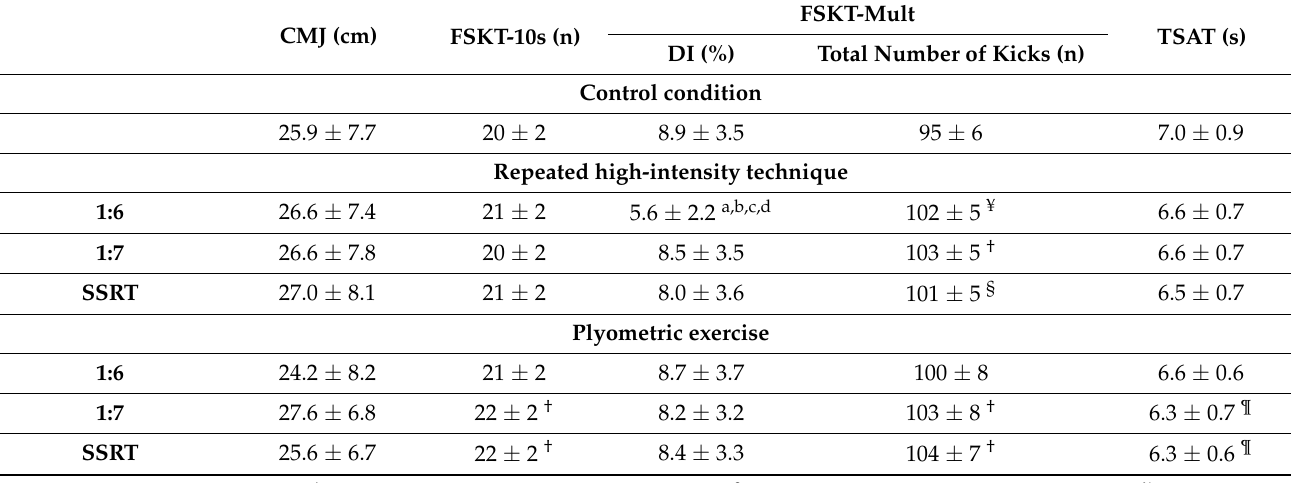
Table 1. Countermovement jump (CMJ), 10 s frequency speed of kick test (FSKT-10s) repetitions, decrement index (DI), and the total number of kicks during multiple sets of FSKT (FSKT-mult) and taekwondo specific agility (TSAT) test during different conditions (values are mean ± SD; n = 27). CMJ (cm) FSKT-10s (n)